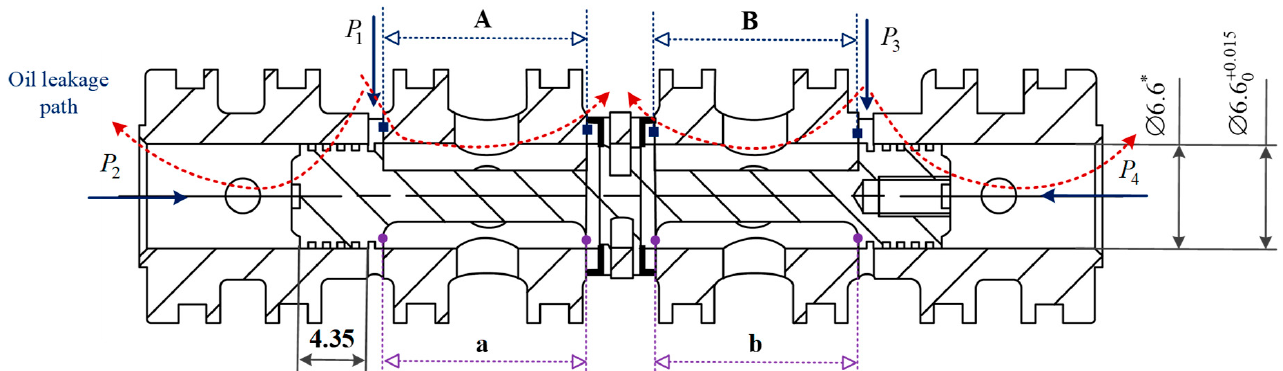
Figure 5. Assembly diagram of precision spool